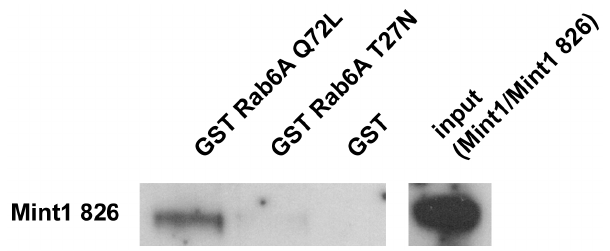
Figure 5. Detection of the Mint1 826 protein. For detection of the Mint1 826 protein GST pulldown assays were performed. 10 m l of Glutathione Sepharose TM 4B beads were coated with 10 m g of GST or the denoted GST fusion protein and then incubated with 1 mg of mouse brain lysate for 3 h at 4 u C. Since Mint1 826 seems to exhibit a relatively low expression level, three samples were pooled for Western blot analyses. input: 15 m g mouse brain lysate.